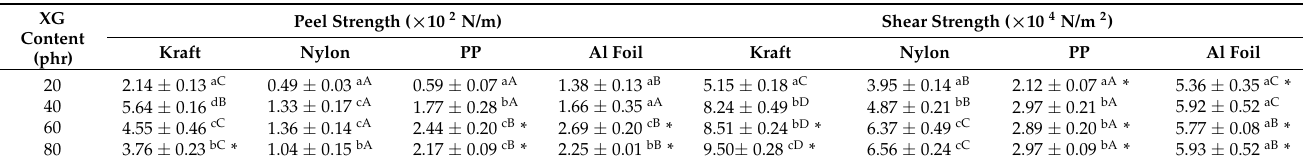
Table 4. Peel and shear strengths of NR-PSA/CO produced with 2 mm nip gap at a mastication time of 15 min with different XG content (20–80 phr).